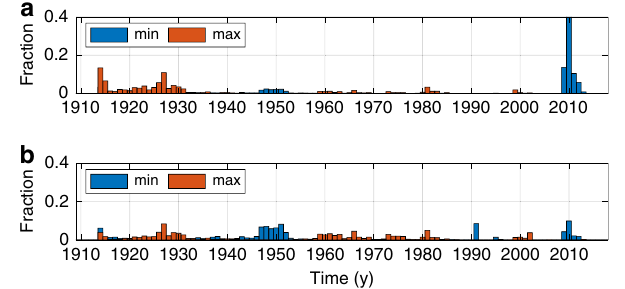
Fig. 4 Timing of Florida Current decadal transport extrema. a Histograms of modeled probabilities that the minimum (blue) and maximum (orange) decadal-average transport occurred centered on a given year. b As in a but histograms were calculated after removing the corresponding long-term trend. See “ Methods ” section for discussion of statistics and uncertainty measures.